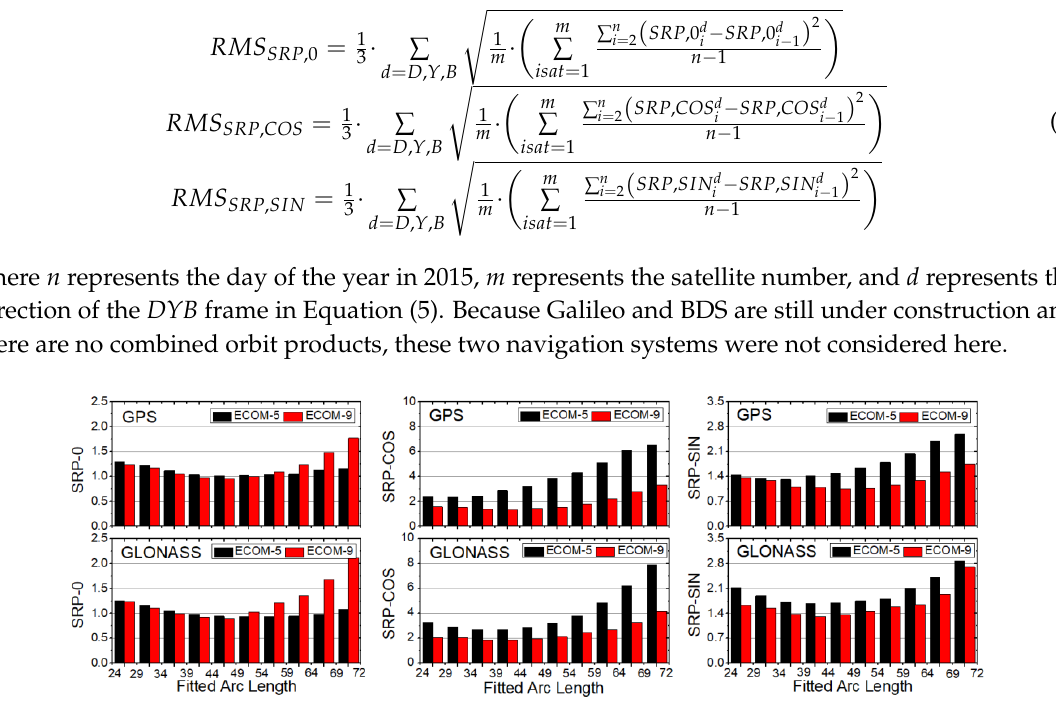
Figure 8. Root mean squares (RMSs) of daily variations in GPS and GLONASS solar radiation pressure (SRP) parameters estimated with various arc lengths over the year 2015 (SRP-0, -COS and -SIN represent the constant and once-per-revolution sine and cosine terms, respectively; unit: 10 −3 ).